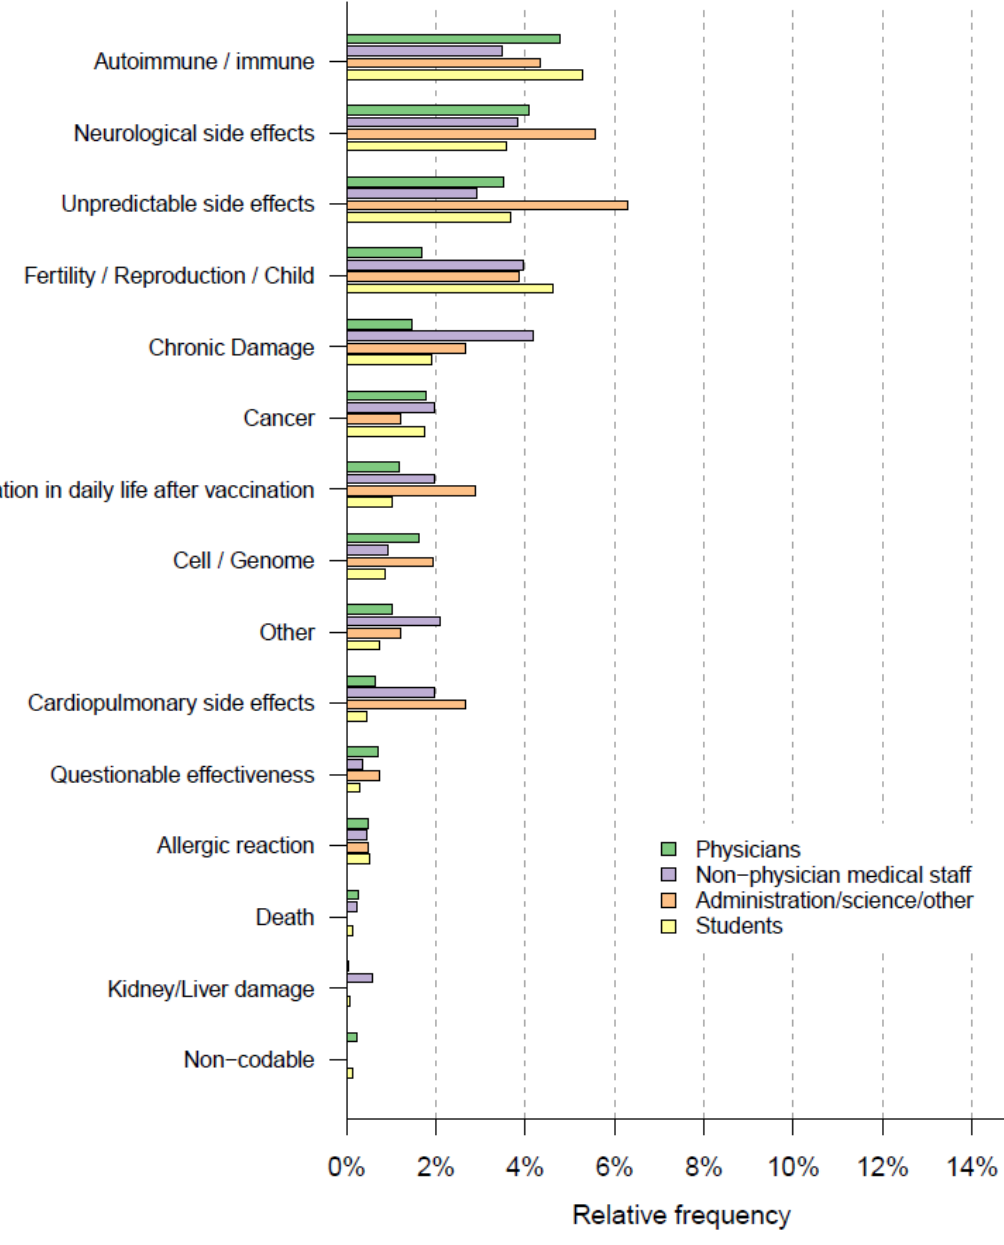
Figure 9. Professional groups and feared long-term side effects. Working in an ICU was not associated with a significant difference in the frequency of feared long-term adverse events (ICU: 167/1525, 15.1%) vs. non-ICU 263/1105, 17.2%, p = 0.144). There were also no significant differences between the frequency of care for COVID-19 patients and feared long-term side effects, as shown in Supplementary Table